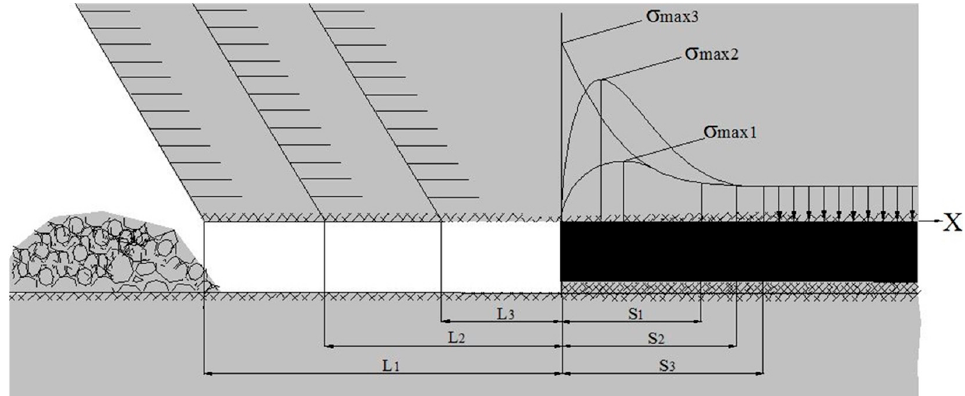
Figure 6. Scheme of explanation of the effect of shearer’s cutting width concerning the rock pressure distribution: L1, L2, L3—width of the zone of supported near-face space; S1, S2, S3—width of the zone of support pressure depending on Ln; σ max1 , σ max2 , σ max3 —maximum value of stresses of the zone of support pressure depending on Ln.